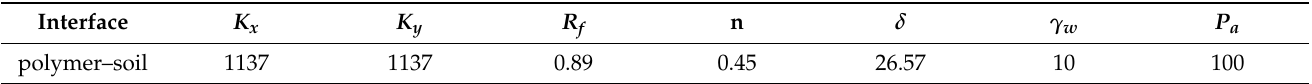
Table 11. Static model parameters of polymer–soil interface.